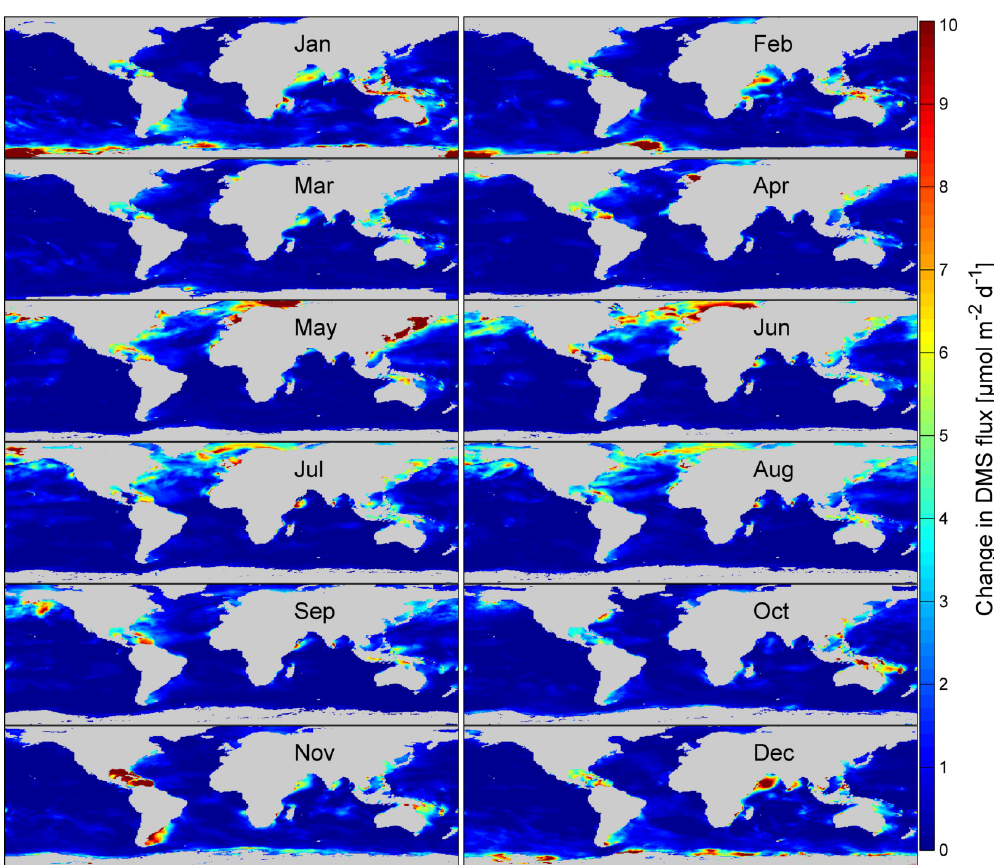
Figure 10. The absolute change of DMS gas transfer due to suppression for each month of 2014. The shown magnitudes denote the reduction by gas transfer suppression. The change is calculated using the bulk flux formula (Eq. 1) and (cid:49)k (Eq. 12).